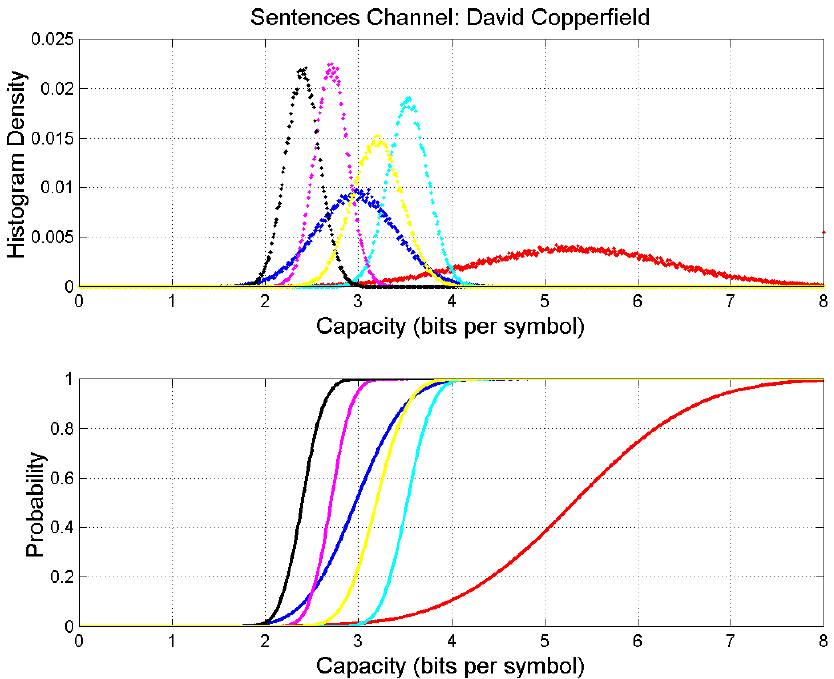
Figure 5. Upper panel : Probability density histograms of self- and cross-channel capacity. David Copperfield : red (output); The Adventures of Oliver Twist : blue; Bleak House : magenta; A Tale of Two Cities ; cyan; Our Mutual Friend : black. Matthew : yellow. Lower panel : Probability distribution func- tions.